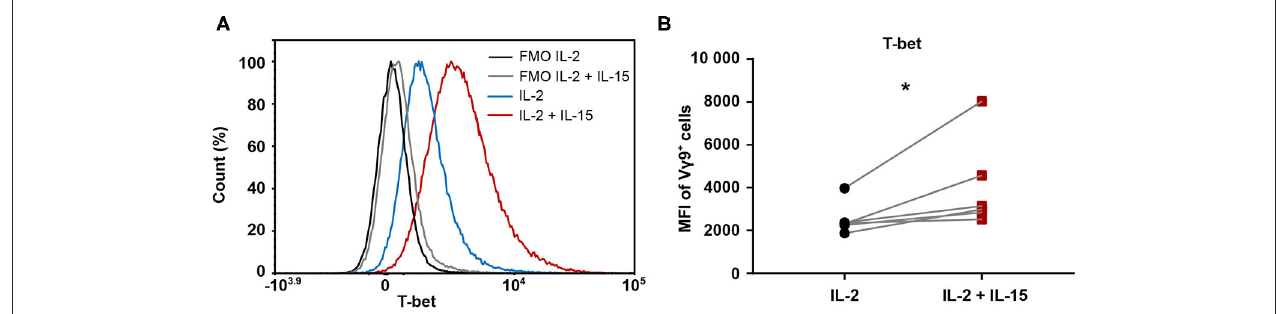
FIGURE 5 | Expression of transcription factor T-bet is increased when including IL-15 during expansion of V γ 9V δ 2T cells. 25-day-expanded V γ 9V δ 2T cells ( n = 6, compiled data from two independent experiments; γδ HD1–4, 11–12) were tested for level of T-bet expression by intracellular staining. (A) Representative histogram from one healthy donor displaying T-bet expression. Fluorescence-minus-one (FMO) controls are marked in black (IL-2) and gray (IL-2/IL-15), while fully stained samples for IL-2-expanded cells are depicted in blue and IL-2/IL-15-expanded cells in red. (B) T-bet expression in IL-2 vs. IL-2/IL-15-expanded cultures, determined by MFI of V γ 9 + cells. Significance of differences between groups were calculated with the Wilcoxon matched-pairs signed-rank test. * p < 0.05, MFI = median fluorescence